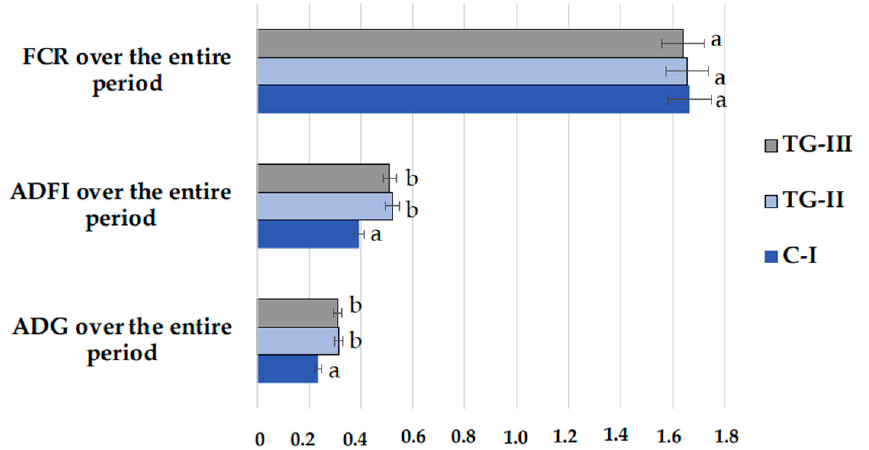
Figure 6. Feed conversion ratio (FCR), average daily feed intake (ADFI), and average daily gain (ADG) over the entire period ( a,b different letters indicate differences among treatments, p < 0.05; C-I—control group TG-II—treatment group with extruded–fermented wheat bran addition; TG-III— treatment group with sugar beet pulp).